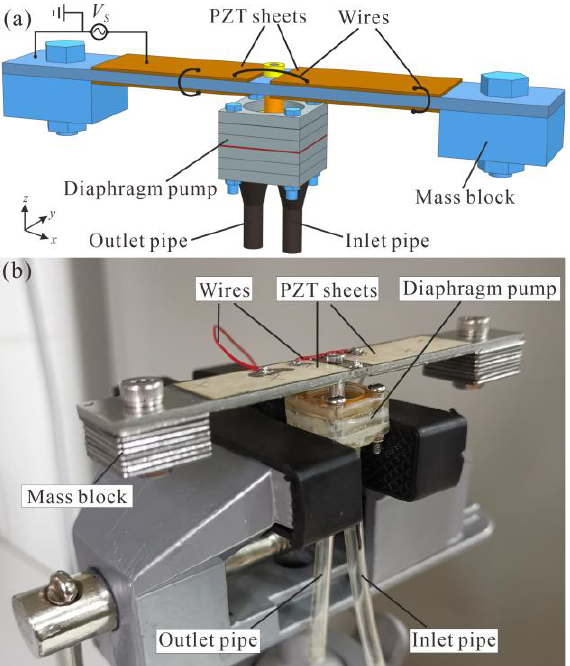
Figure 10. ( a ) Mechanical structure and ( b ) a prototype of the proposed piezoelectric pump.